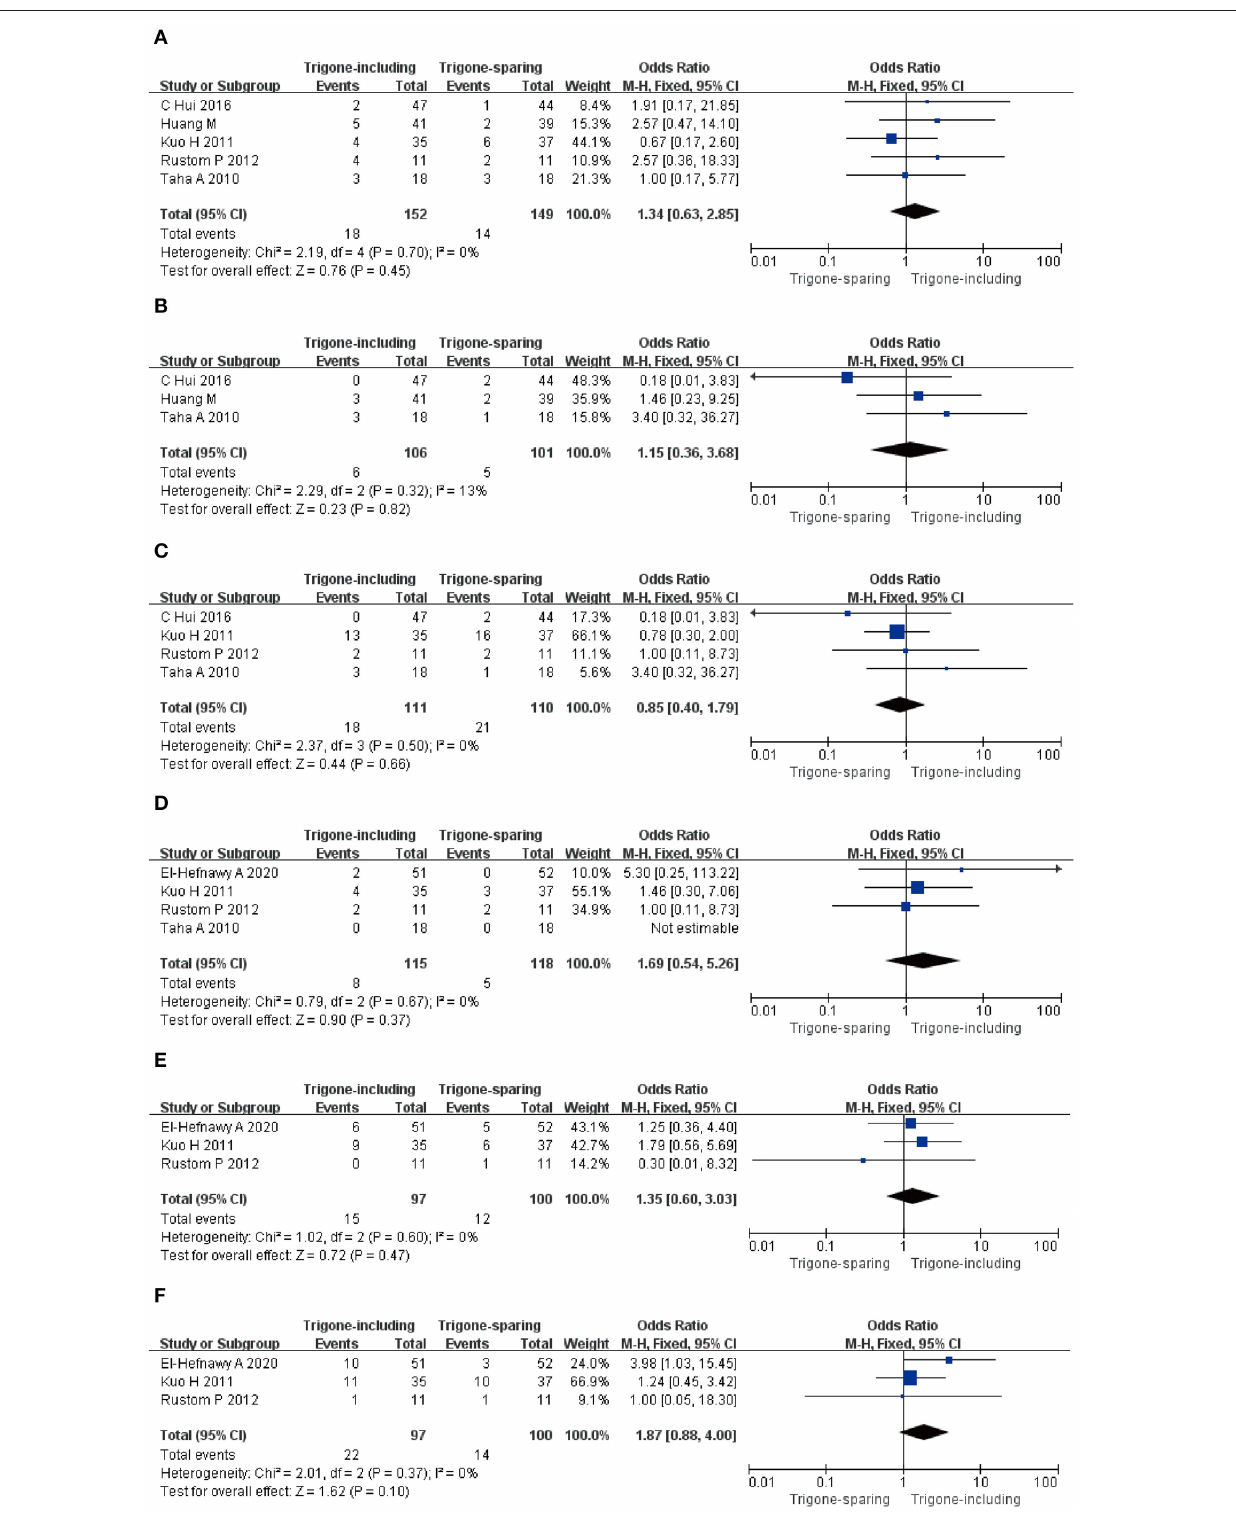
Frontiers in Neurology |